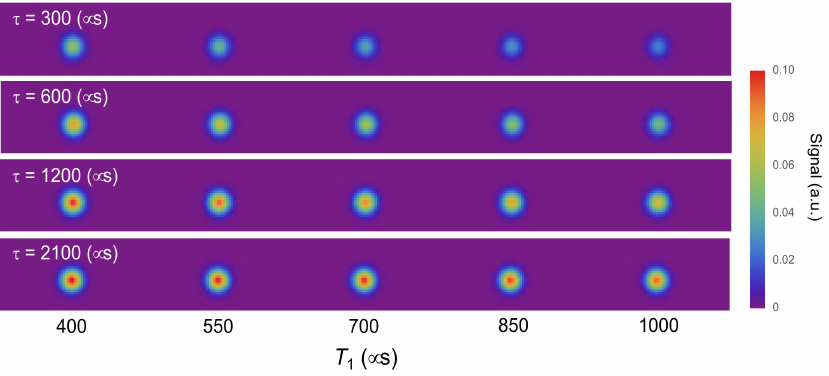
Figure 3. Simulation of T 1 -weighted images constructed from each τ value. T 1 is simulated in the range typically observed for changes in 100-nm nanodiamond